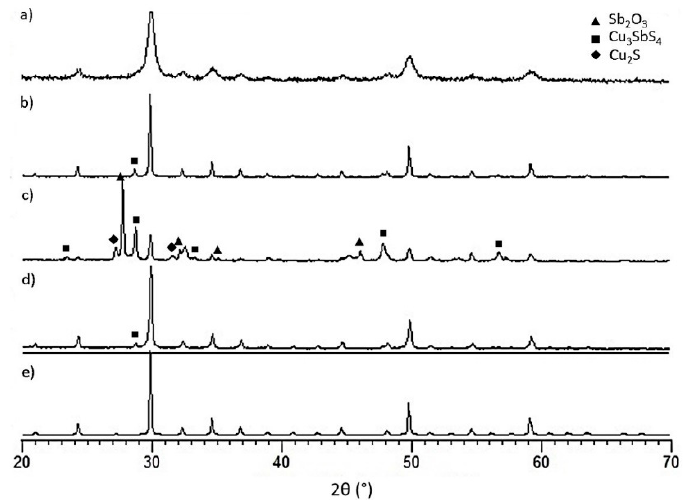
Figure 6. XRD spectra for ( a ) Tetrahdrite powders ( b ) as sintered sample ( c ) aged THD at 350 ◦ C for 48 h without coating ( d ) aged THD at 350 ◦ C for 48 h with coating and ( e ) Cu 12 Sb 4 S 13 PDF Card